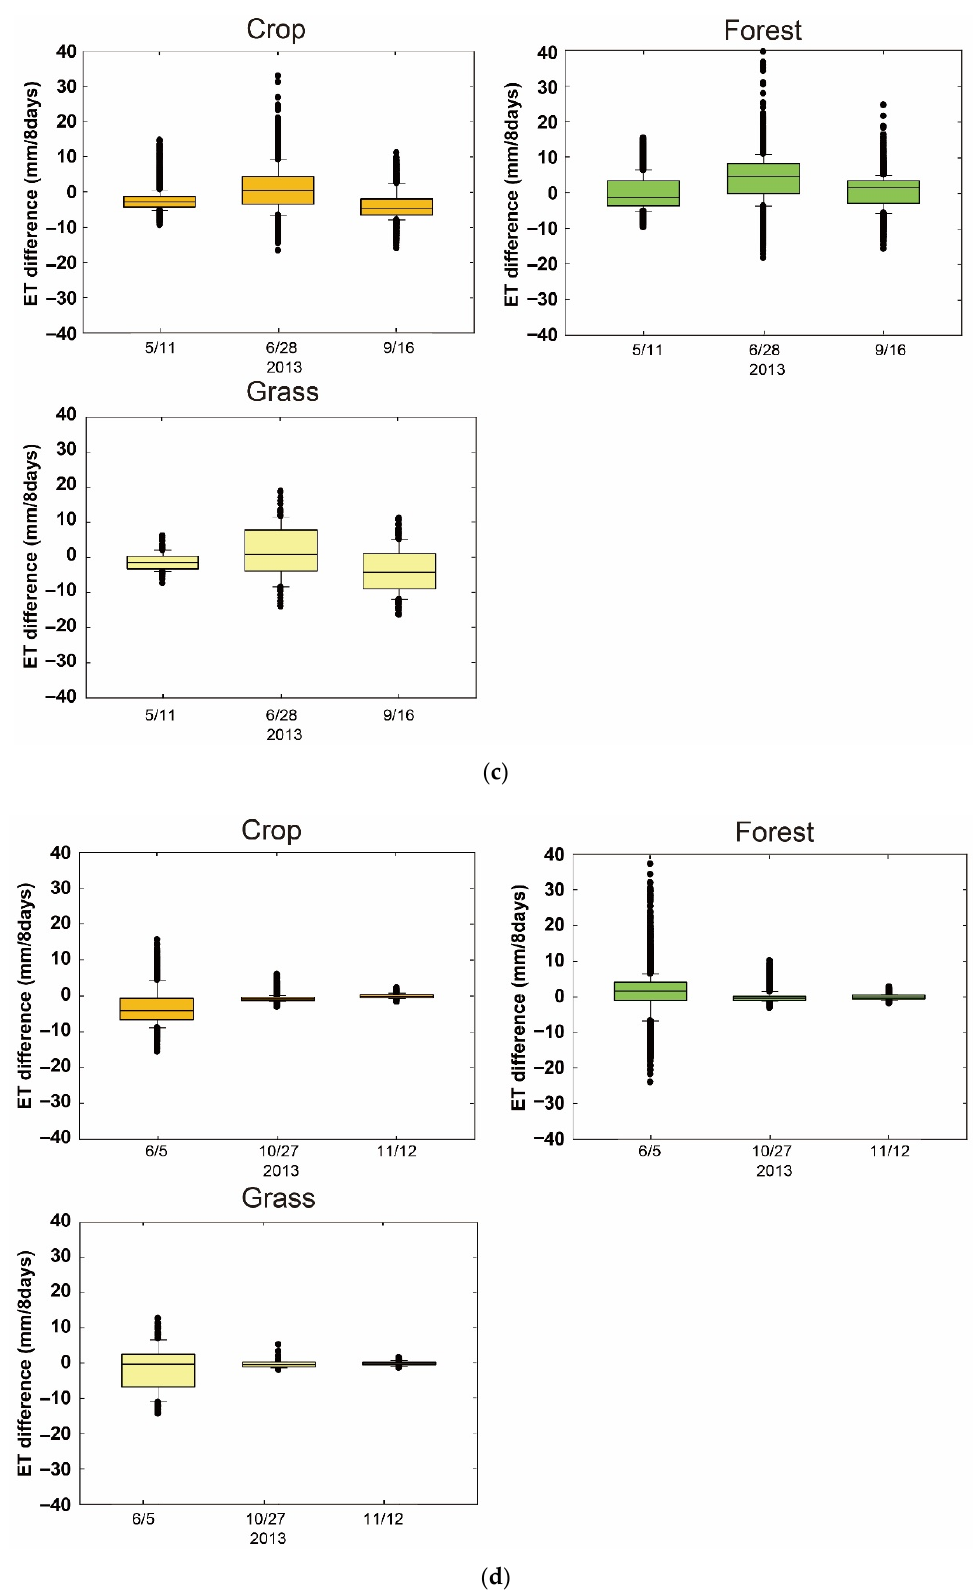
Figure 10. Boxplots of difference between Landsat downscaled 30 m ET and MODIS ET in forest, crop, shrub and grass areas for: ( a ) Site 1; ( b ) Site 2; ( c ) Site 3; and ( d ) Site 4.